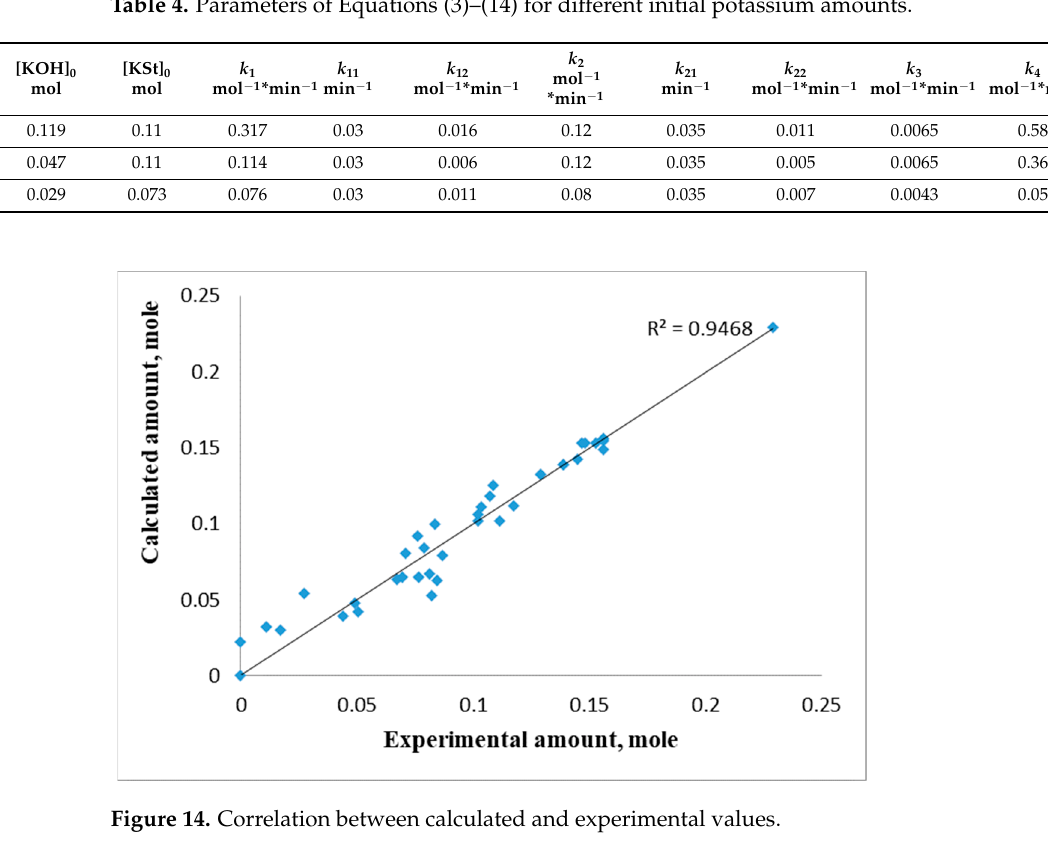
Figure 13. Experimental (dots) and calculated (lines) amounts of potassium compounds ( a ) and PET ( b ) at 170 °C, and the initial amount of PET of 0.156 mol: Experiment 1: with the addition of KOH; Experiment 2: standard experiment with crude glycerol; Experiment 3: with the addition of pure glycerol. Table 4. Parameters of Equations (3)–(14) for different initial potassium amounts.